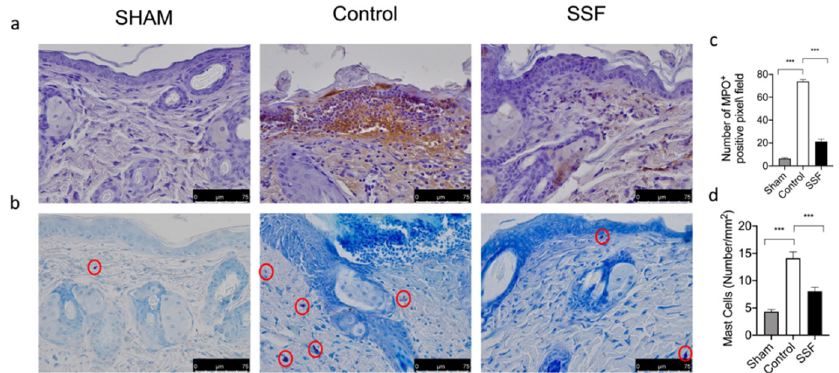
Figure 5. Upper panels ( a , c ) shows the immunohistochemical analysis of MPO in sham animals and in the wound bed 14 days after wounding. The group treated with SSF showed a significant decrease in MPO expression. Lower panels ( b , d ) shows the presence of mast cells in the wound bed, indicated by blue toluidine staining, from the sham group, control wound group, and wound + SSF treatment group, respectively. Data are presented as means ± SEM images of 10 mice for each group. *** p < 0.001.